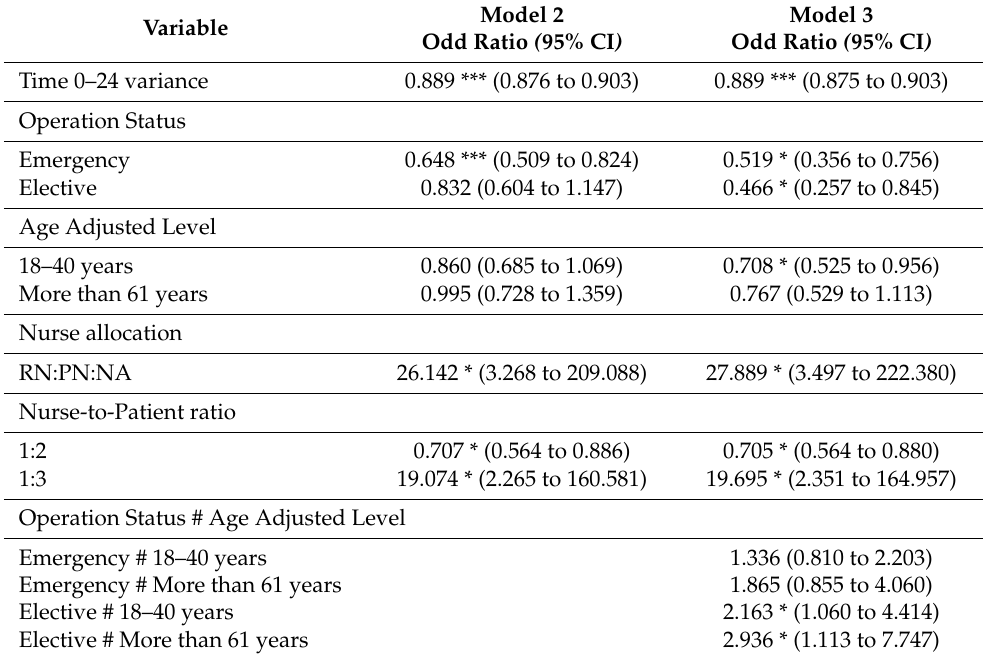
Table 2. Estimated odds ratio and variance components for the multi-level mixed model and the repeated measure data logistic regression